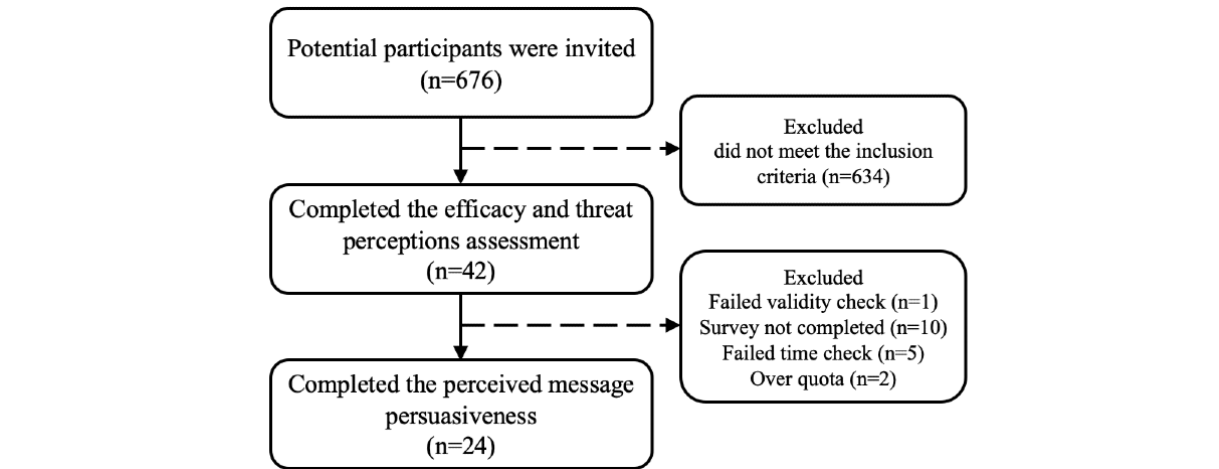
Figure 4. Patients with obstructive sleep apnea message testing process.